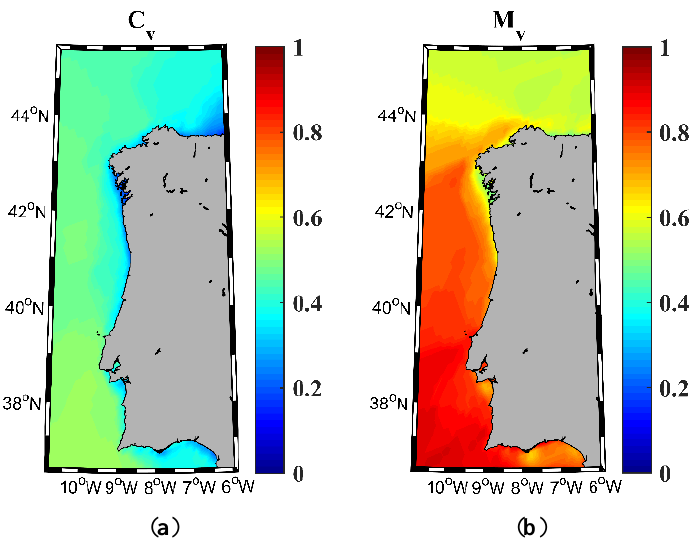
Figure 4. Variability indices for wind energy resource. Variation coefficient ( a ) and monthly variability ( b ) in the NW Iberian Peninsula for the near future (2026–2045).